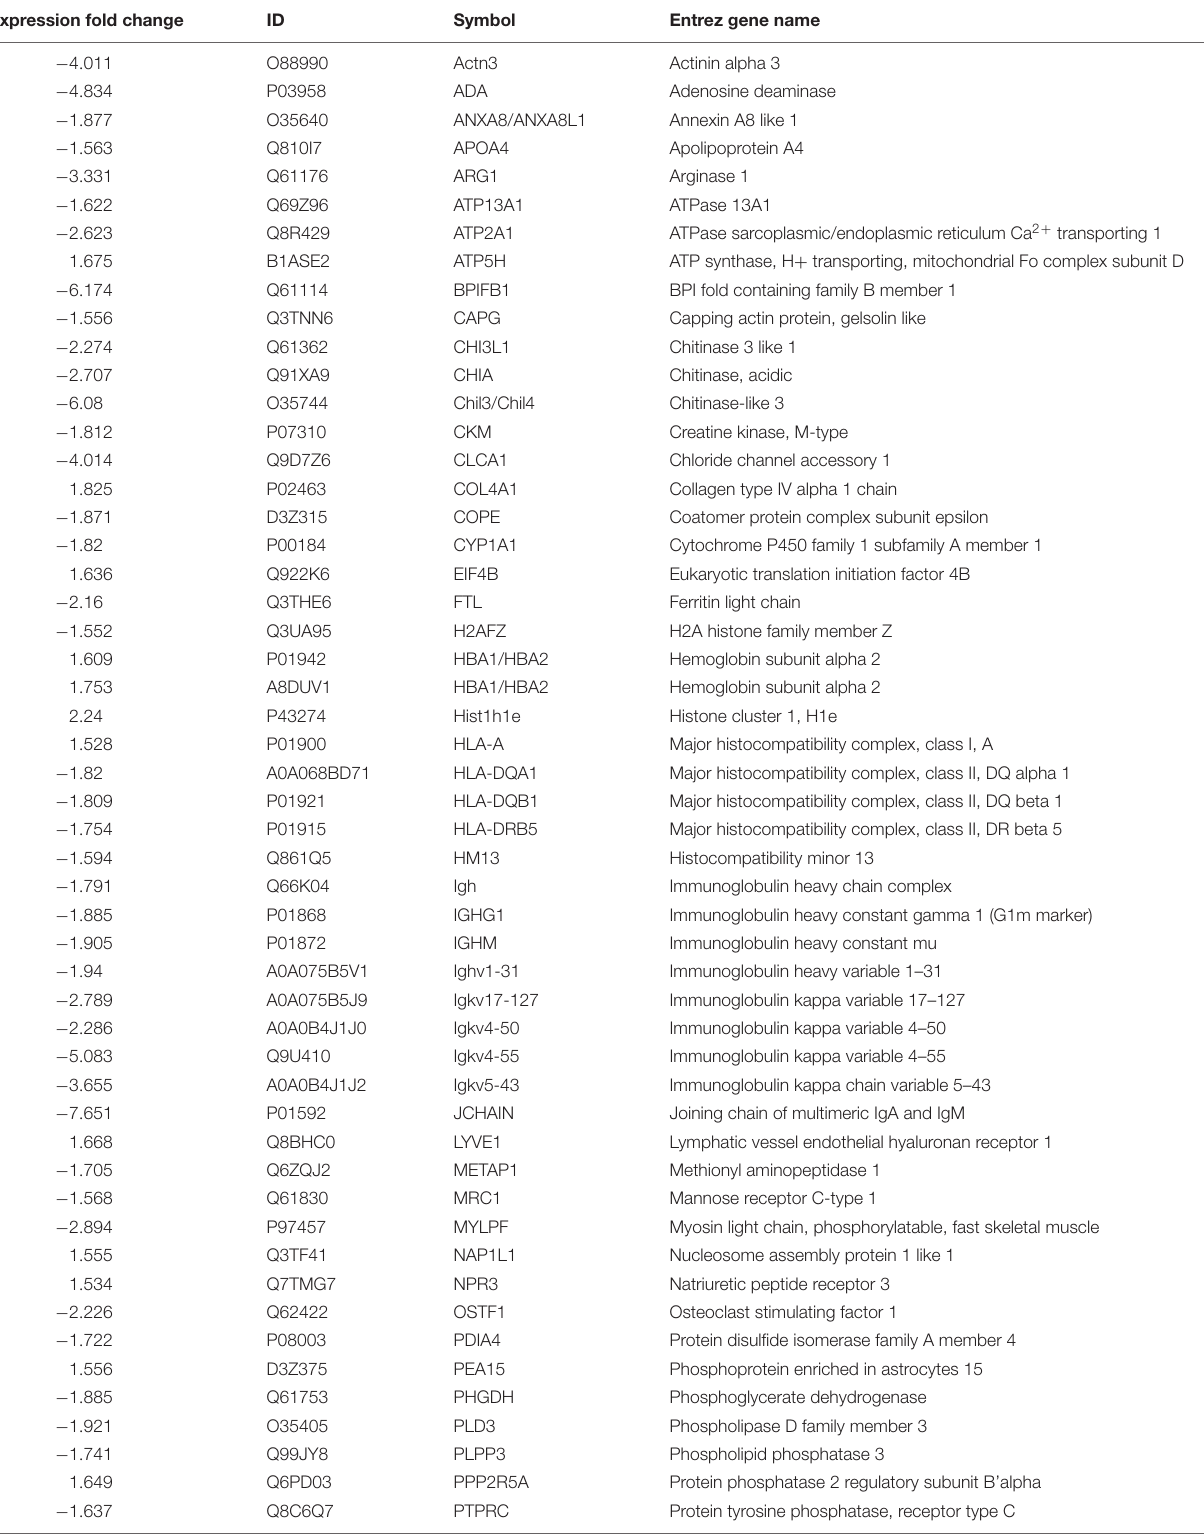
TABLE 4 | Differentially expressed proteins (DEPs) in the CON group compared with the MOD group. Expression fold change ID